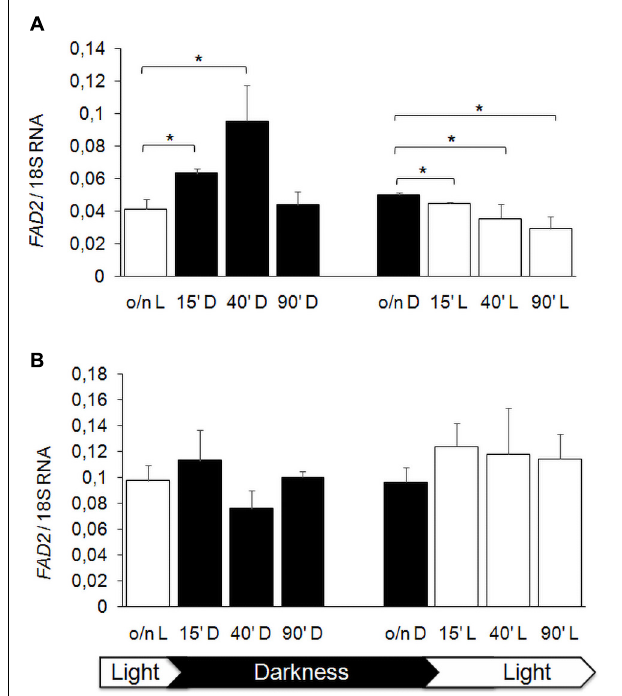
FIGURE 7 | FAD2 transcription after light and darkness shifts. Wild type (A) and Klmga2 (cid:49) (B) strain cells were grown overnight in light (o/n L) or darkness (o/n D) and then shifted to darkness (D) or light (L), respectively, for 15, 40, and 90 min before nucleic acid extraction and qRT-PCR. Values are averages of three independent determinations with SD. Transcription of ribosomal 18S gene was used as reference. * indicates p <